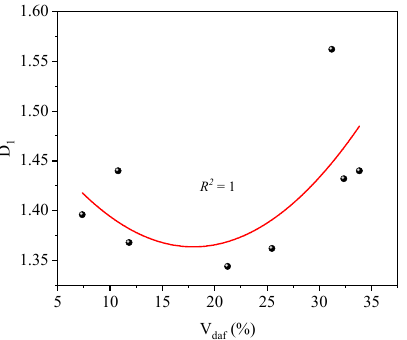
Figure 7. Relationship between V daf and fractal dimensions ( D 1 ).